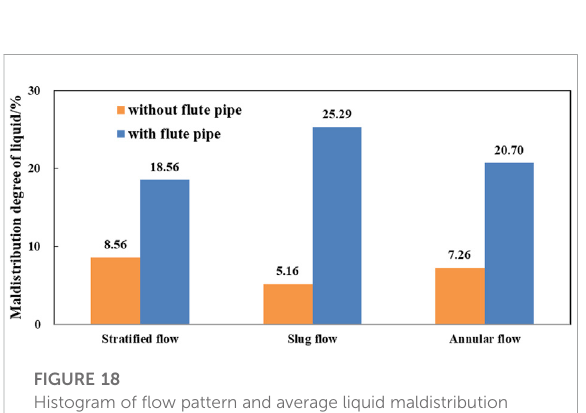
FIGURE 18 Histogram of fl ow pattern and average liquid maldistribution degree in the horizontal